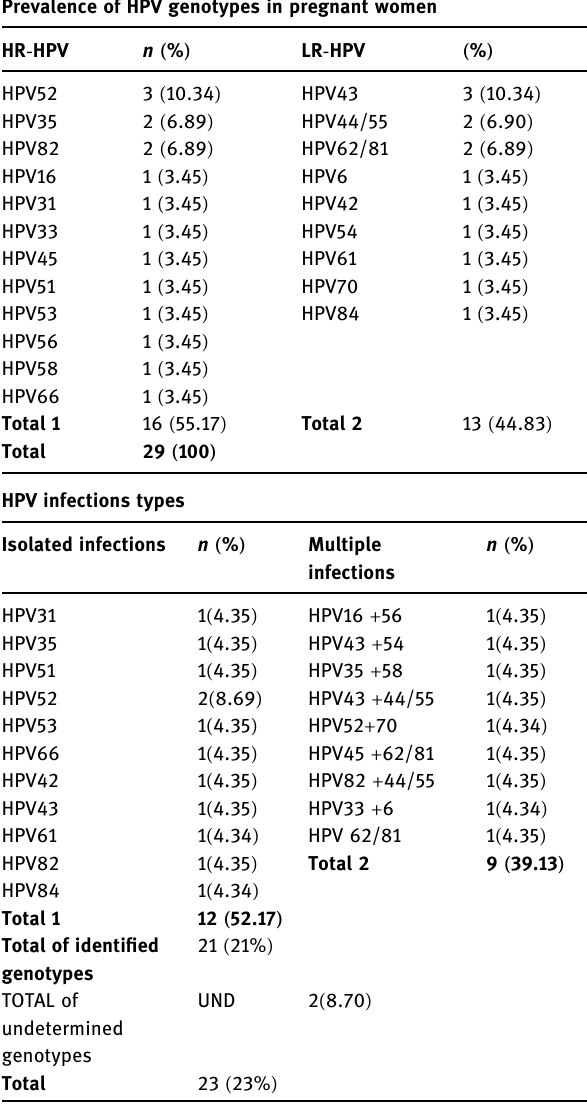
Table 2: Prevalence and distribution of HR - HPV and LR - HPV geno - types in pregnant women